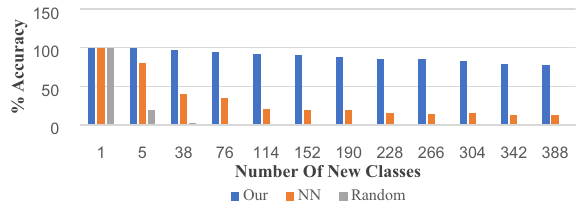
Figure 9. Open set of new class recognition. NN represents the nearest neighbor classifier, the horizontal axis represents a total of 10 batches with the number of classes 1–388, and the vertical axis represents the one-shot recognition